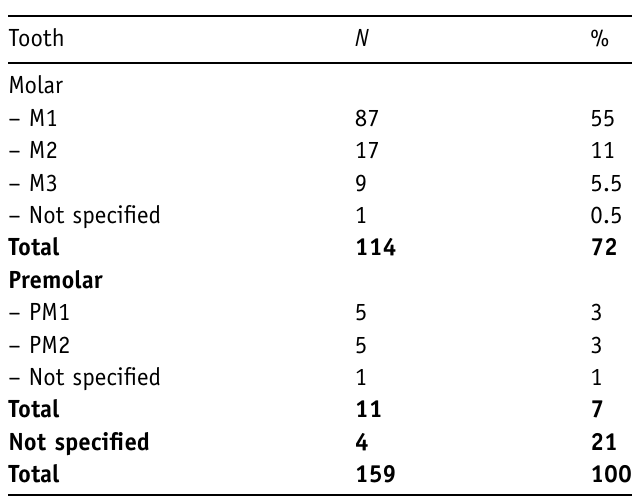
Table II. Distribution of teeth displacement according to the tooth type.